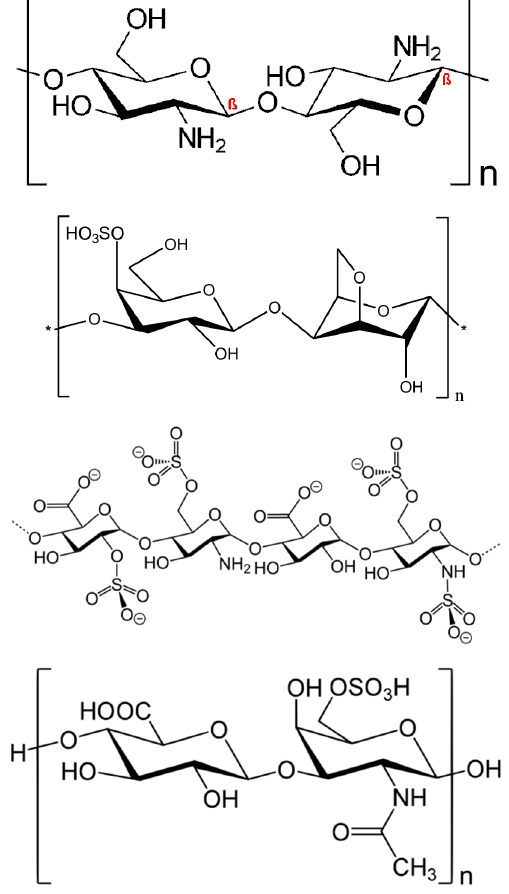
Figure 7. The chemical structural representation of different biodegradable polysaccharide hydrogels for bone-tissue engineering application.